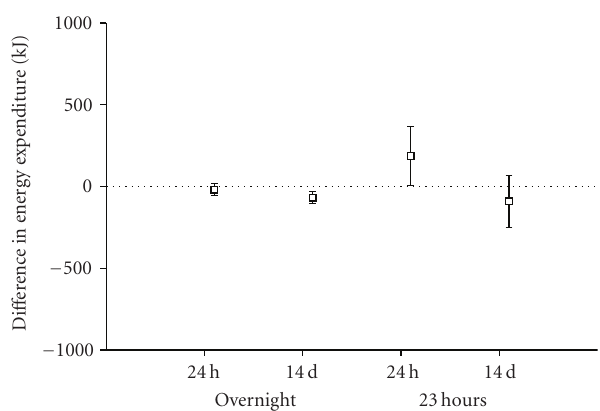
Figure 1: Mean di ff erences and standard deviations of di ff erences between measures of energy expenditure, made overnight and over 23 hours, and repeated after a 24-hour or 14-day interval. Untreated (placebo) subjects, n = 6.